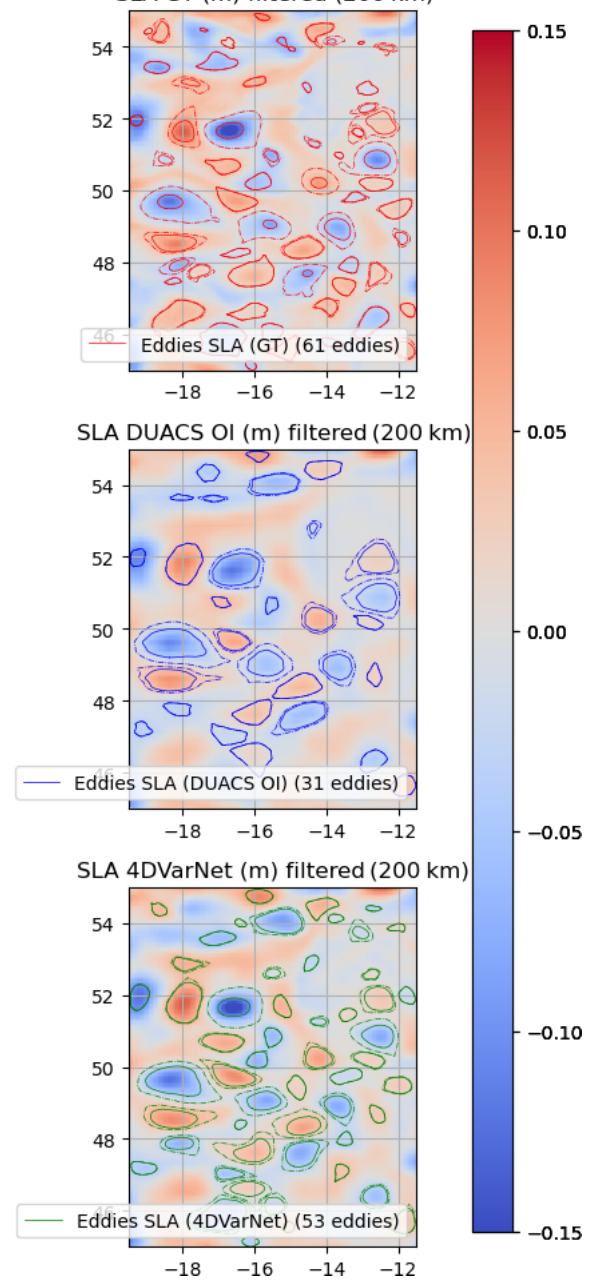
Figure C3. Eddies detected on the OSMOSIS domain (25 October 2012) over SSH (four nadirs).